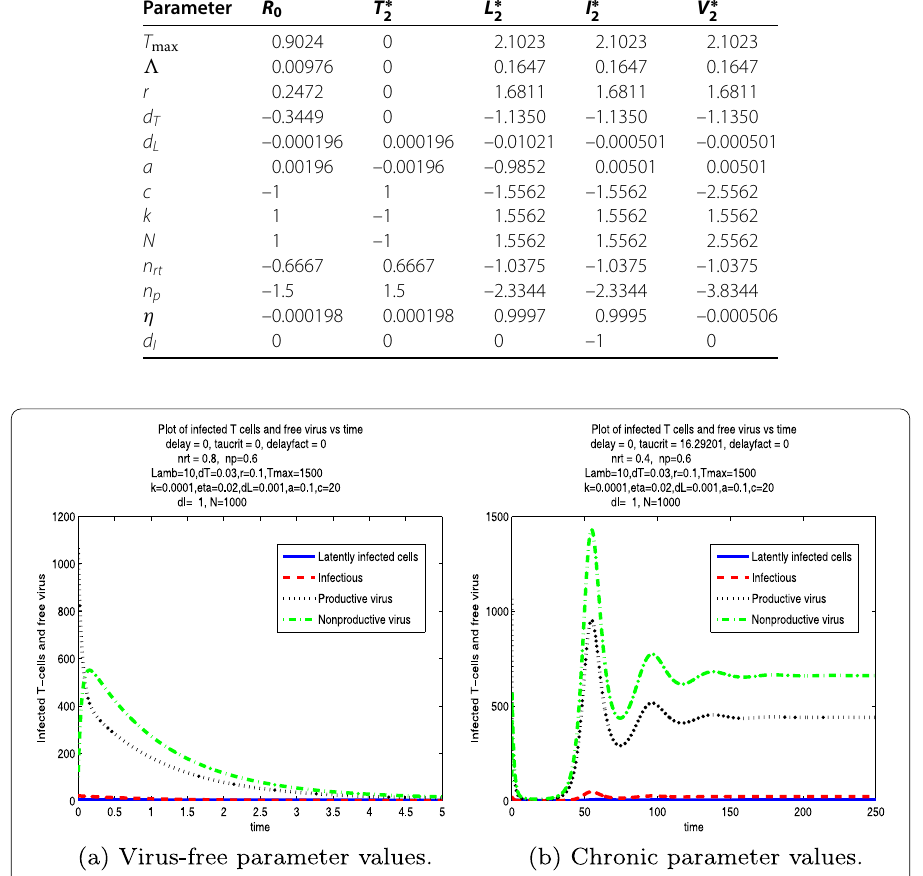
Figure 2 Plots of populations vs time for virus-free and chronic parameter